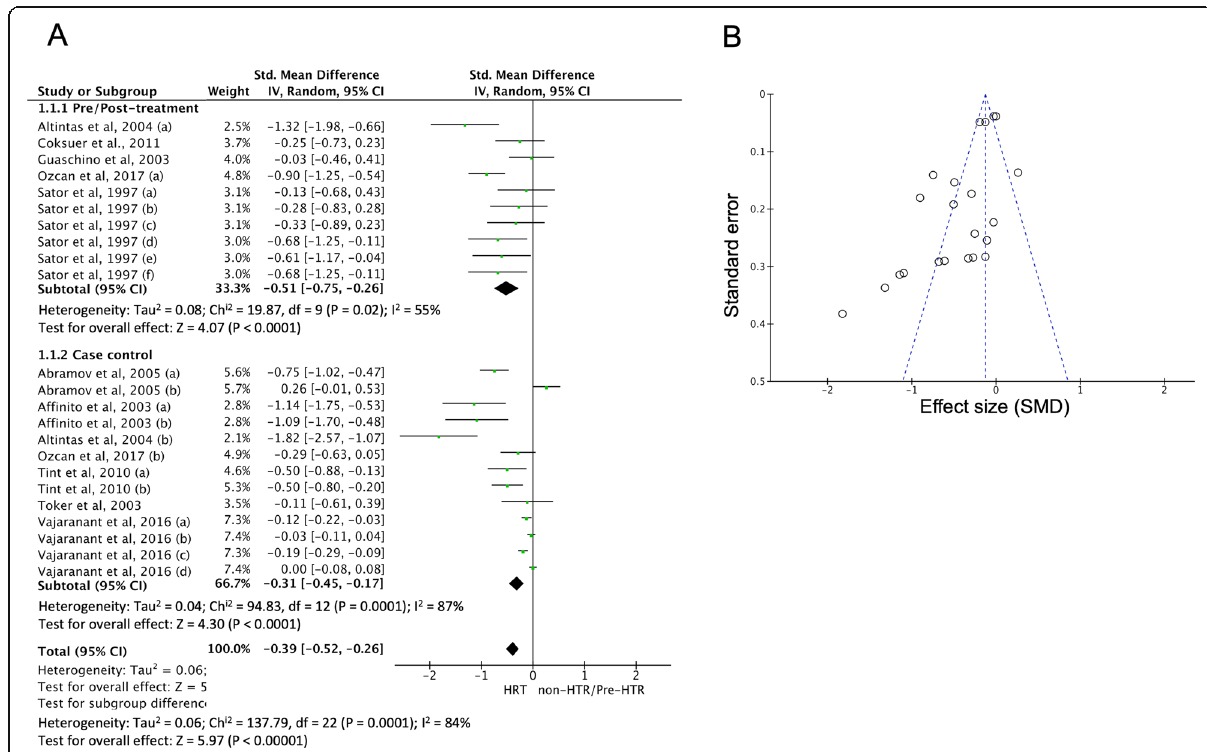
Fig. 1 a Forest plot of the pooled studies evaluating IOP in HRT-treated patients and controls. b Begg ’ s funnel plot to evaluate publication bias